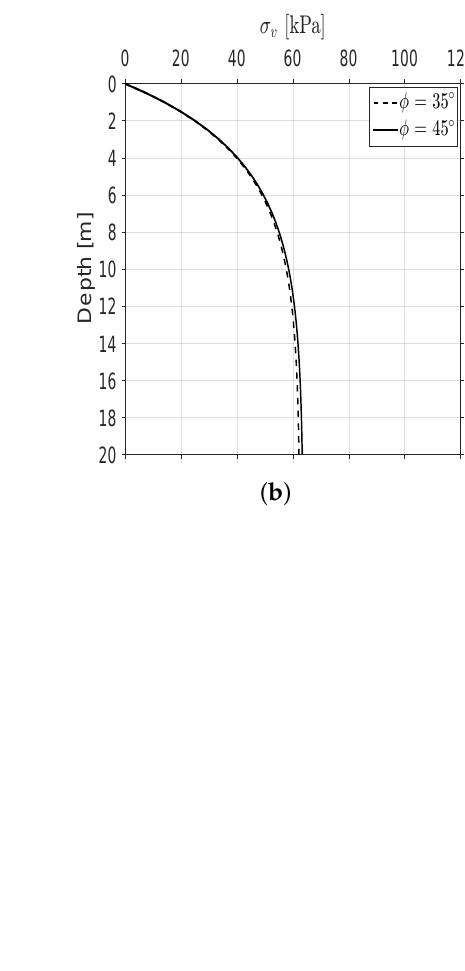
Figure 12. K silo · tan ϕ as a function of the friction angle of the cover layer obtained from different approaches.